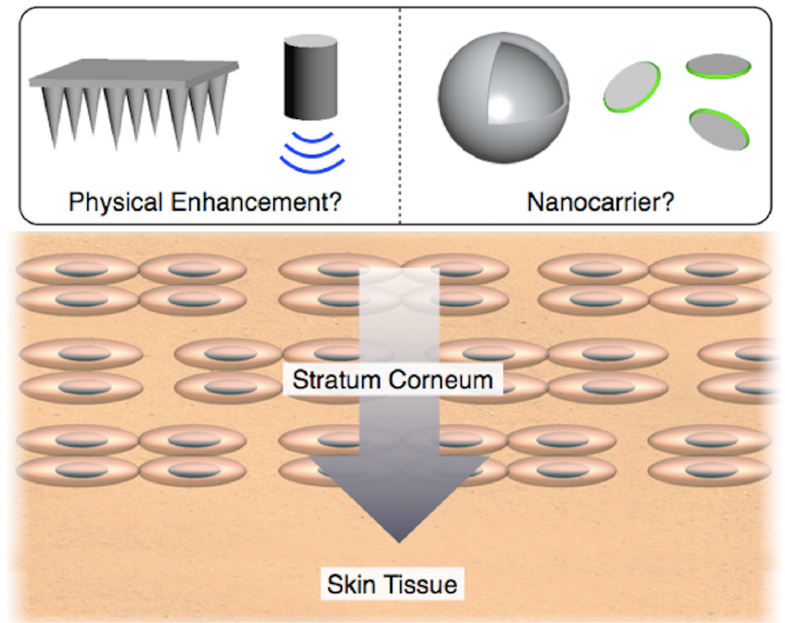
Figure 1. Schematic illustration of representative strategies in transdermal drug delivery system (TDDS) using physical enhancements and nanocarriers.